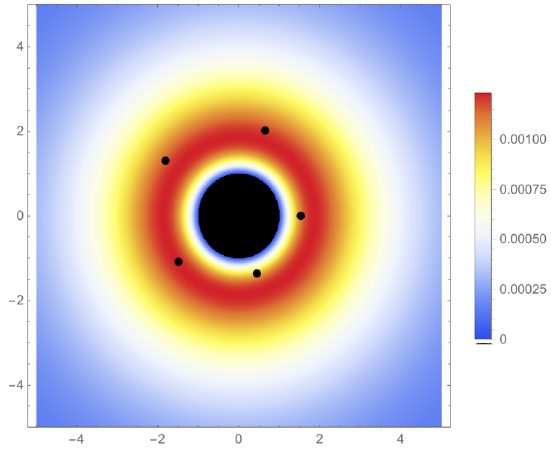
Figure 1 . Example of black hole with halo and probe black holes (we ignore the mutual interaction between probes) with different charges. The red region corresponds to the peak of the massive vector field: the three probes lying further away from the horizon are stable, while the other two are metastable. More details in section